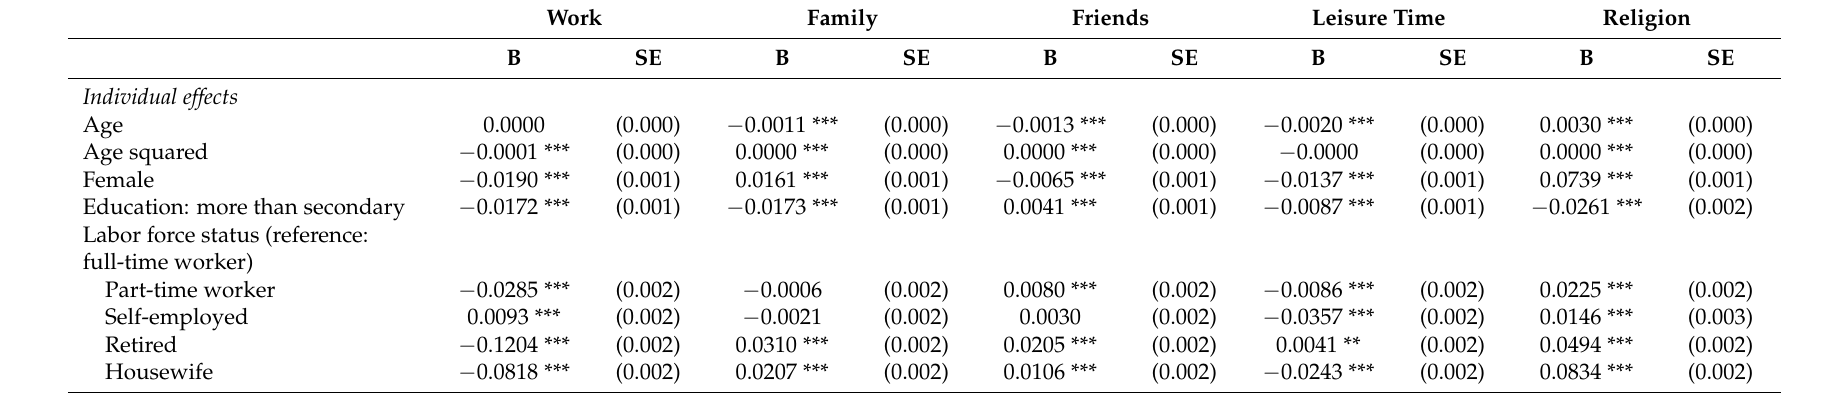
Table A8. The HAPC models of the relative importance of life aspects, with control